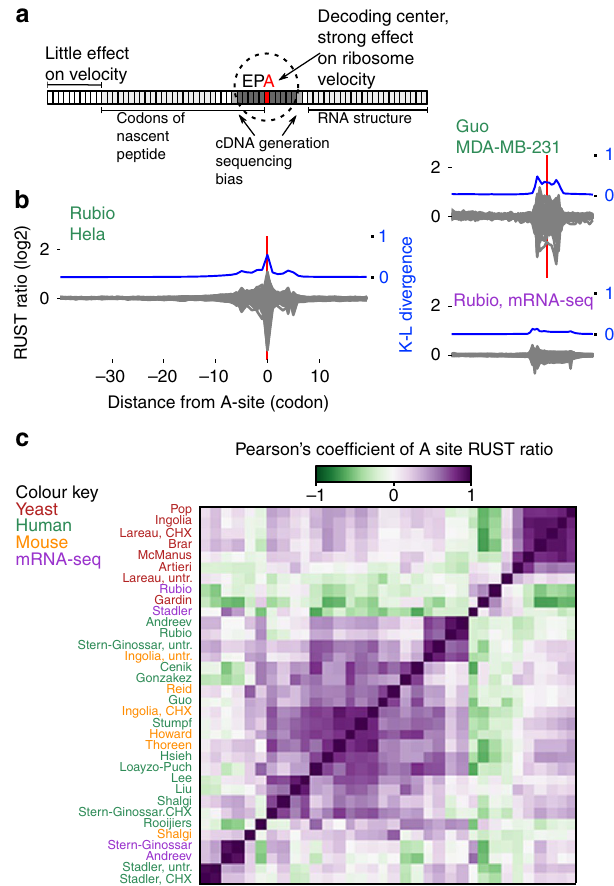
Figure 2 | Evaluation of ribo-seq data sets with RUST. ( a ) Anatomy of the ribosome footprint displaying position-specific mRNA sequence influence on ribo-seq read density. ( b ) RUSTcodon metafootprint profiles of selected ribo-seq and mRNA-seq data sets used in this study. The individual RUST ratio values of 61 sense codons across the mRNA are displayed. The resulting grey area is a superposition of each 61 curves. The corresponding Kullback–Leibler divergence (K–L) is shown in blue. The protocol details for each data set are summarized in Table 1. ( c ) Heatmap displaying the pairwise similarity of codon RUST ratios at the A-site, as measured by the Pearson’s correlation, for ribo-seq data sets of human (green), yeast (red) and mouse (orange). Also included are human mRNA-seq data (violet). The data sets are indexed by the name of the first author. The clustering was done with Scipy using the ‘Euclidean’ distance metric with ‘single’